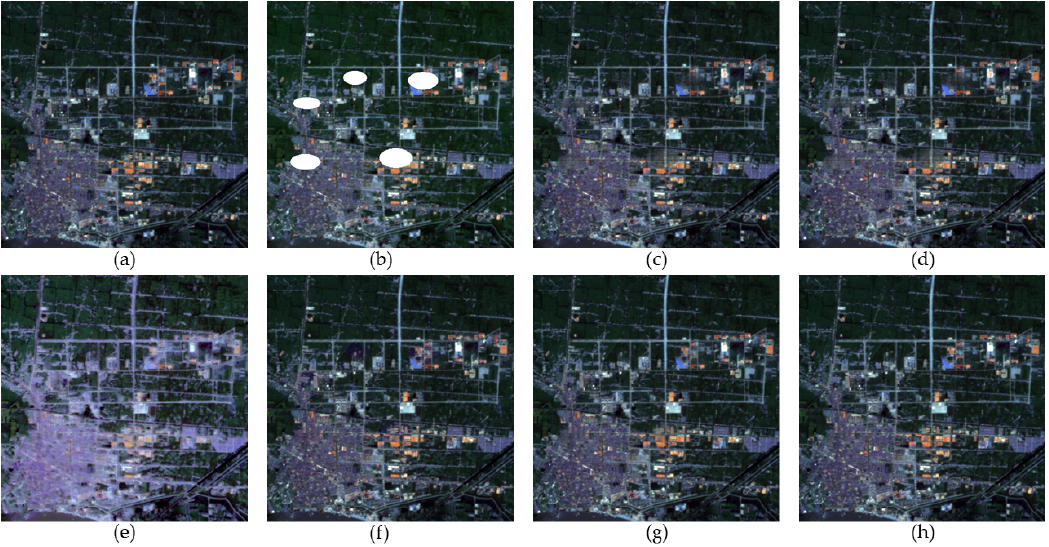
Figure 7. Gaofen-1 WFV images for the first simulated experiment: ( a ) original clean image; ( b ) simulated cloud image; ( c )–( h ) the results of FaLRTC, HaLRTC, TRPCA, TVLRSDC, TOS, and TSSTO, respectively.